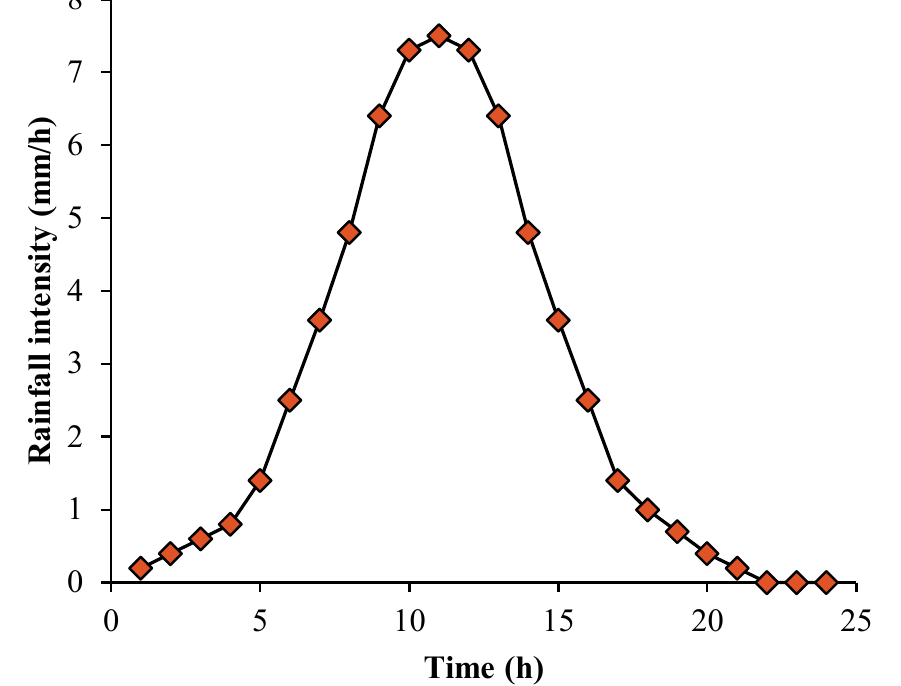
Figure 3. Rainfall intensity over time.